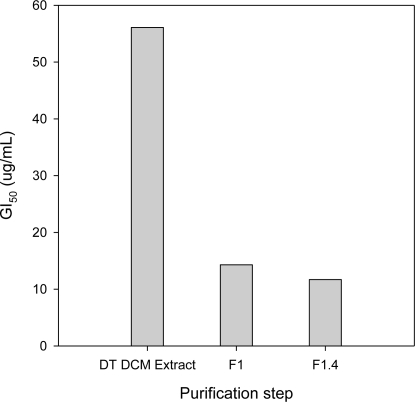
GI50 (μg·mL−1) of DT DCM extract, F1 fraction and F1.4 sub-fraction on MCF-7.